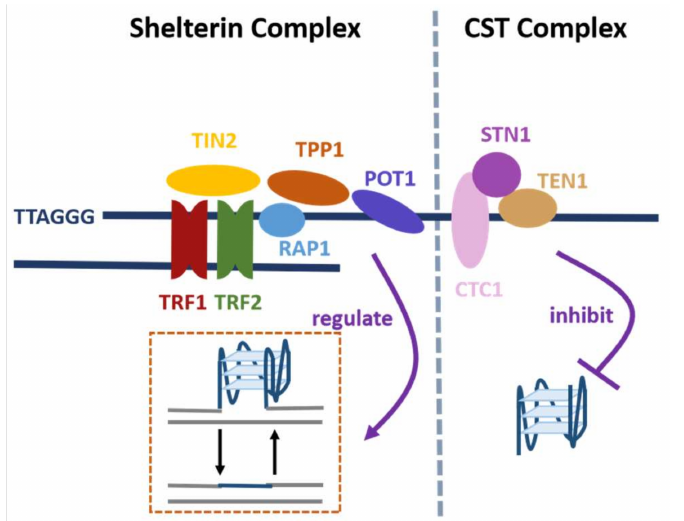
Figure 3. Schematic diagram of the telomere-associated protein complexes shelterin and CST. Shel- terin and CST play crucial roles in telomere maintenance. TPP1-POT1 subunit of shelterin regulates the folding and unwinding of G4 structures. CST could resolve and prevent the formation of G4